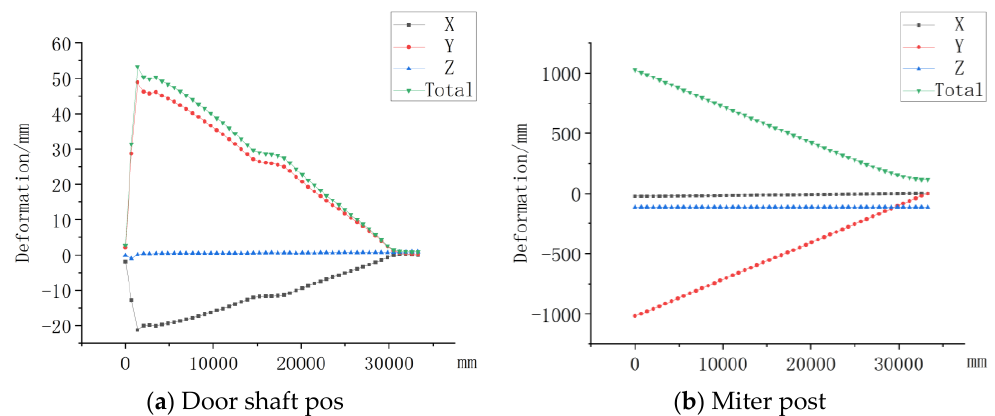
Figure 18. ( a ) Deformation in different directions of the shaft column, ( b ) Deformation of the miter column of the gate without the back tie rod under the door-closing condition. The same finite element analysis is performed on the gate with back tie rods. The deformation cloud diagram of the gate, the gate shaft column, and the miter column is shown in Figure 19, and the maximum deformation of the gate as a whole and different parts are provided in Table 6.